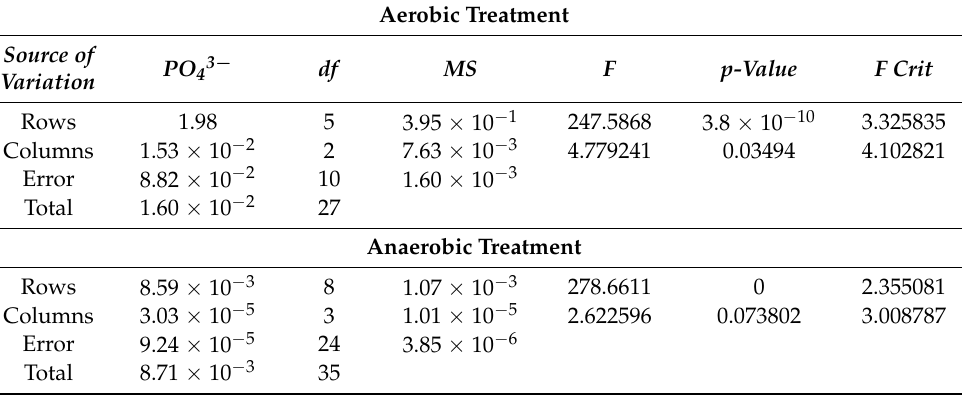
Table 4. Analysis of variance (ANOVA) test of phosphorous removal of aerobic and anaerobic